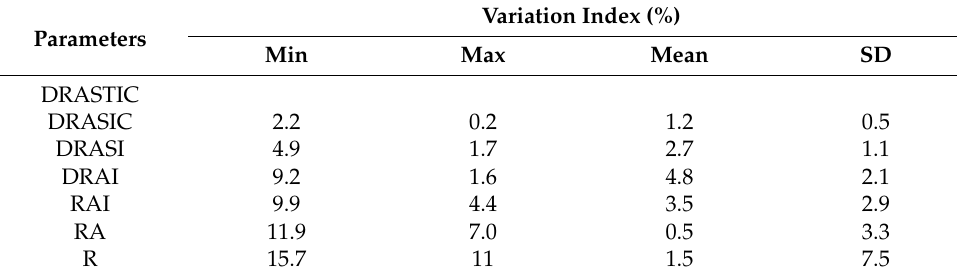
Table 5. Statistics of the multi-map-removal sensitivity analysis.